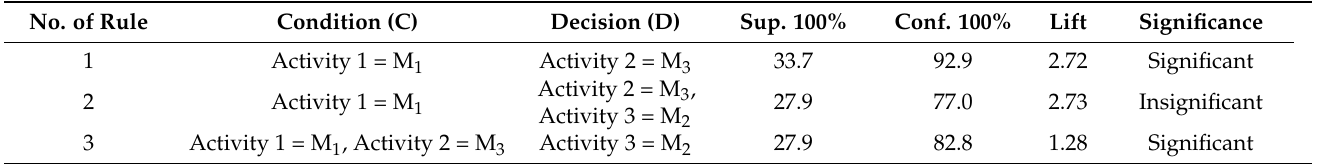
Table 9. Association rules according to the best patterns.